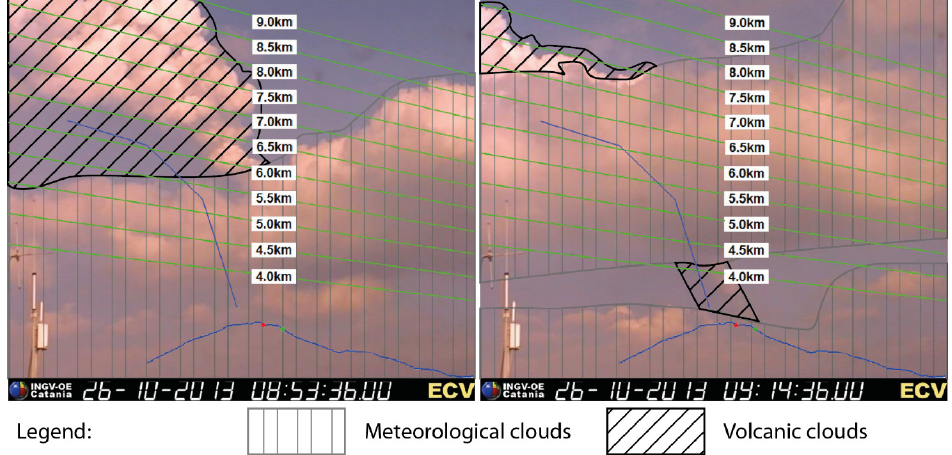
Figure 8. Plume height retrieval from ECV camera frames (at 08:53:36 and 09:14:36) using Scollo et al.’s (2014) [53] grid (green lines). The blue lines are Etna’s outline and the direction of the plume ascent (wind direction dependent). The meteorological and volcanic clouds are highlighted respectively in grey and black hatching.